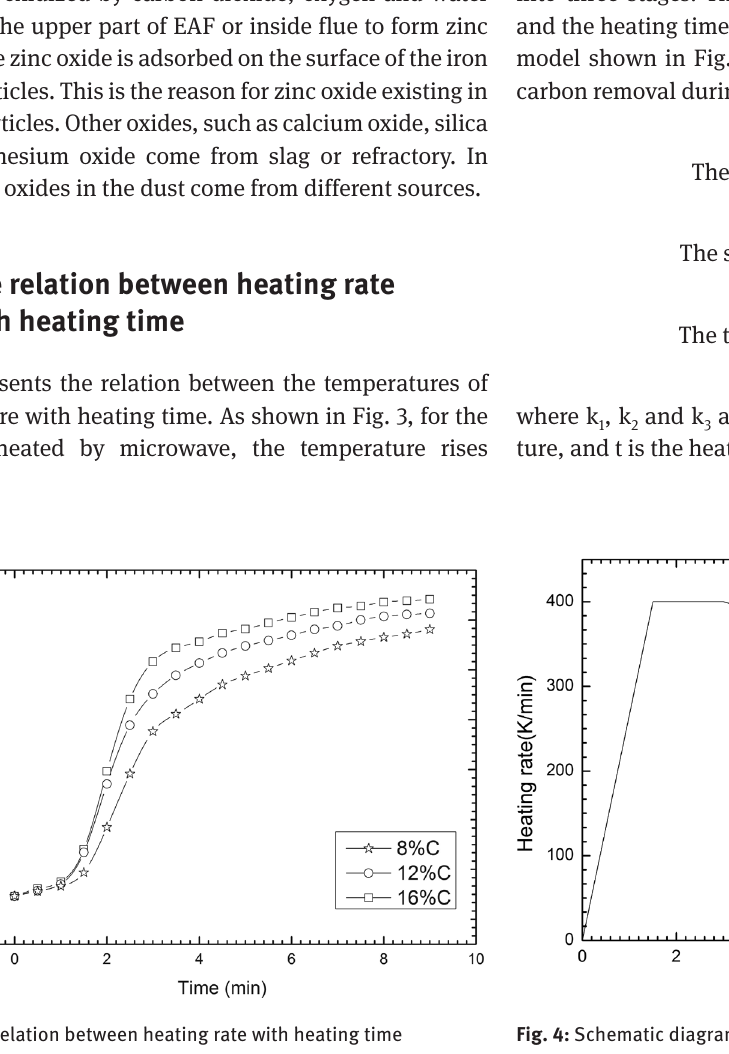
Fig. 3: The relation between heating rate with heating time Fig. 4: Schematic diagram of the model for the heating